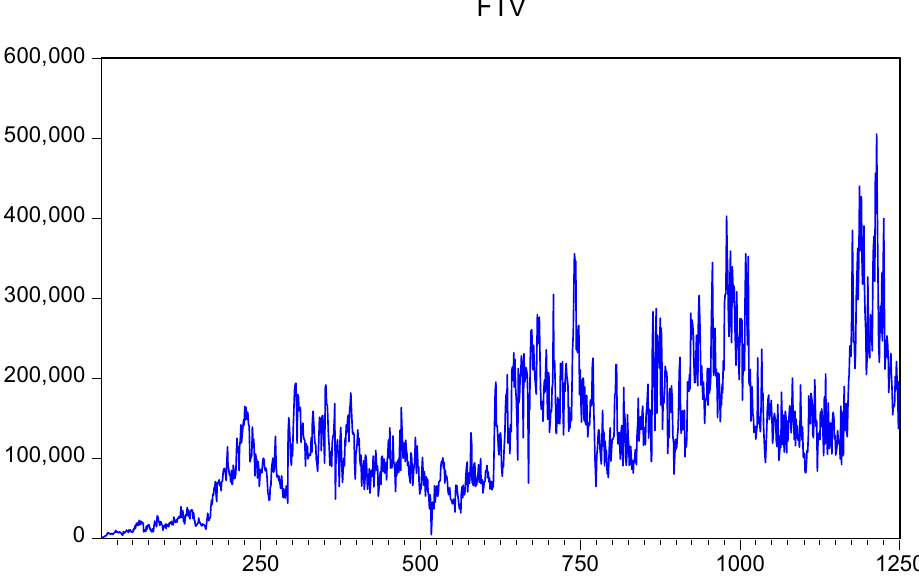
Figure 2. Daily index futures trading volume from 10 August 2017 to 10 August 2022.